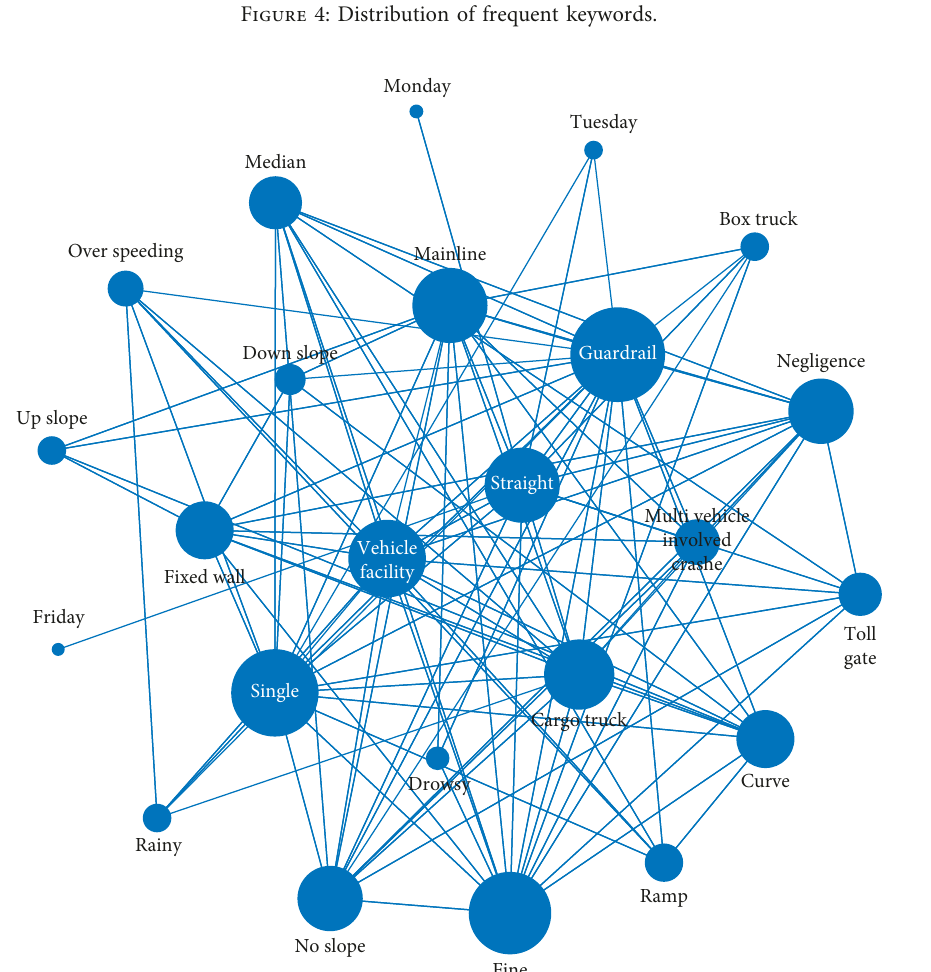
Figure 5: Network graph for association among keywords.